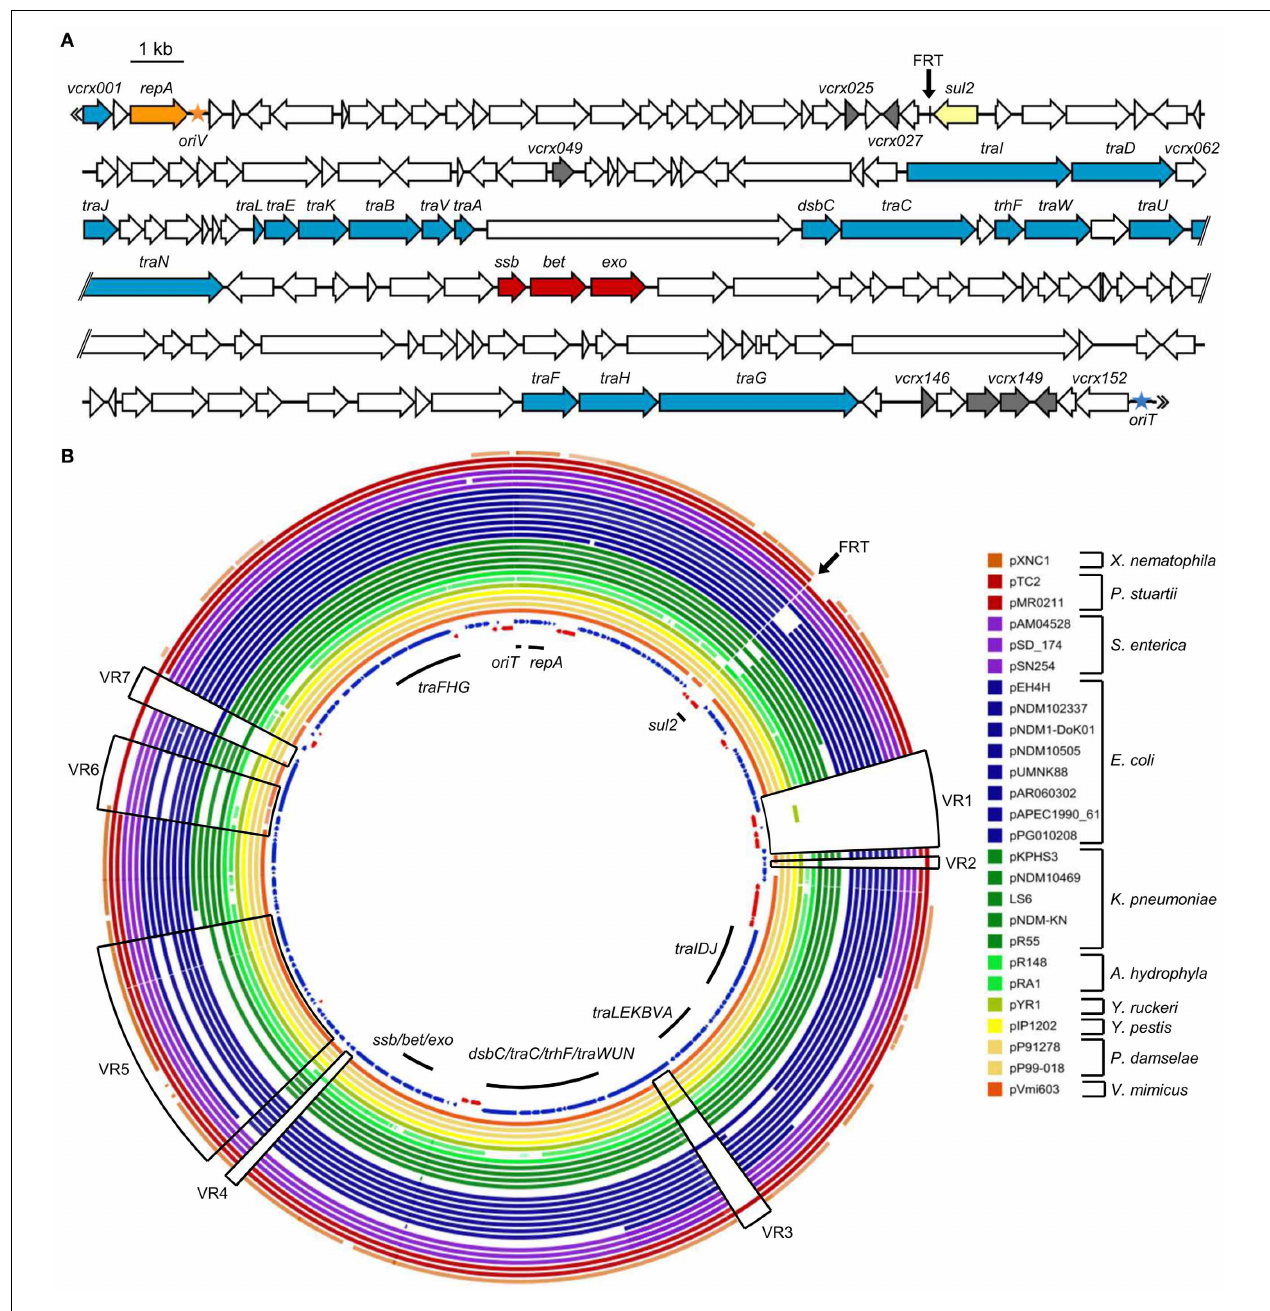
FIGURE 3 | Sequence analysis of pVCR94 (cid:2) X. (A) Schematic representation of the genetic organization of pVCR94 (cid:2) X. The location and orientation of ORFs are indicated by arrowed boxes. The color of the arrowed boxes depicts the putative function or relationships of each ORF deduced from functional analyses and BLAST comparisons: white, unknown function; blue, conjugative transfer; orange, replication; yellow, antibiotic resistance; gray, regulation; red, homologous recombination. The origin of replication ( oriV ) and the origin of transfer ( oriT ) are symbolized by an orange and a blue star, respectively. The position of the scar resulting from the deletion of the multidrug resistance gene cluster is indicated (FRT site). (B) Genetic comparison of pVCR94 (cid:2) X and other sequenced IncA/C plasmids. A BLAST Atlas was constructed with the pVCR94 (cid:2) X sequence set as the reference (innermost circle). All completely sequenced IncA/C plasmids available in